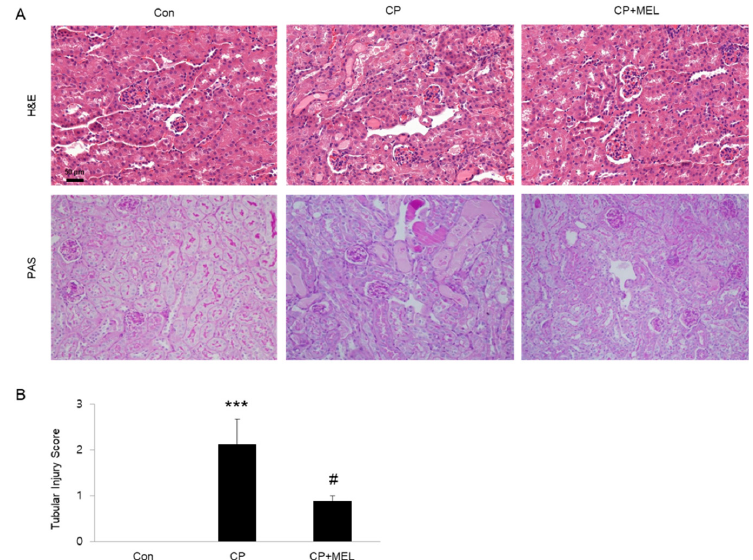
Figure 2. Effects of melatonin (MEL) on renal histology in mice treated with cisplatin (CP). ( A ) Representative images of hematoxylin and eosin (H&E) and periodic acid-Schiff (PAS) staining. Scale bar: 50 µ m. ( B ) Tubular injury score. *** P < 0.001 vs. Con. # P < 0.05 vs.